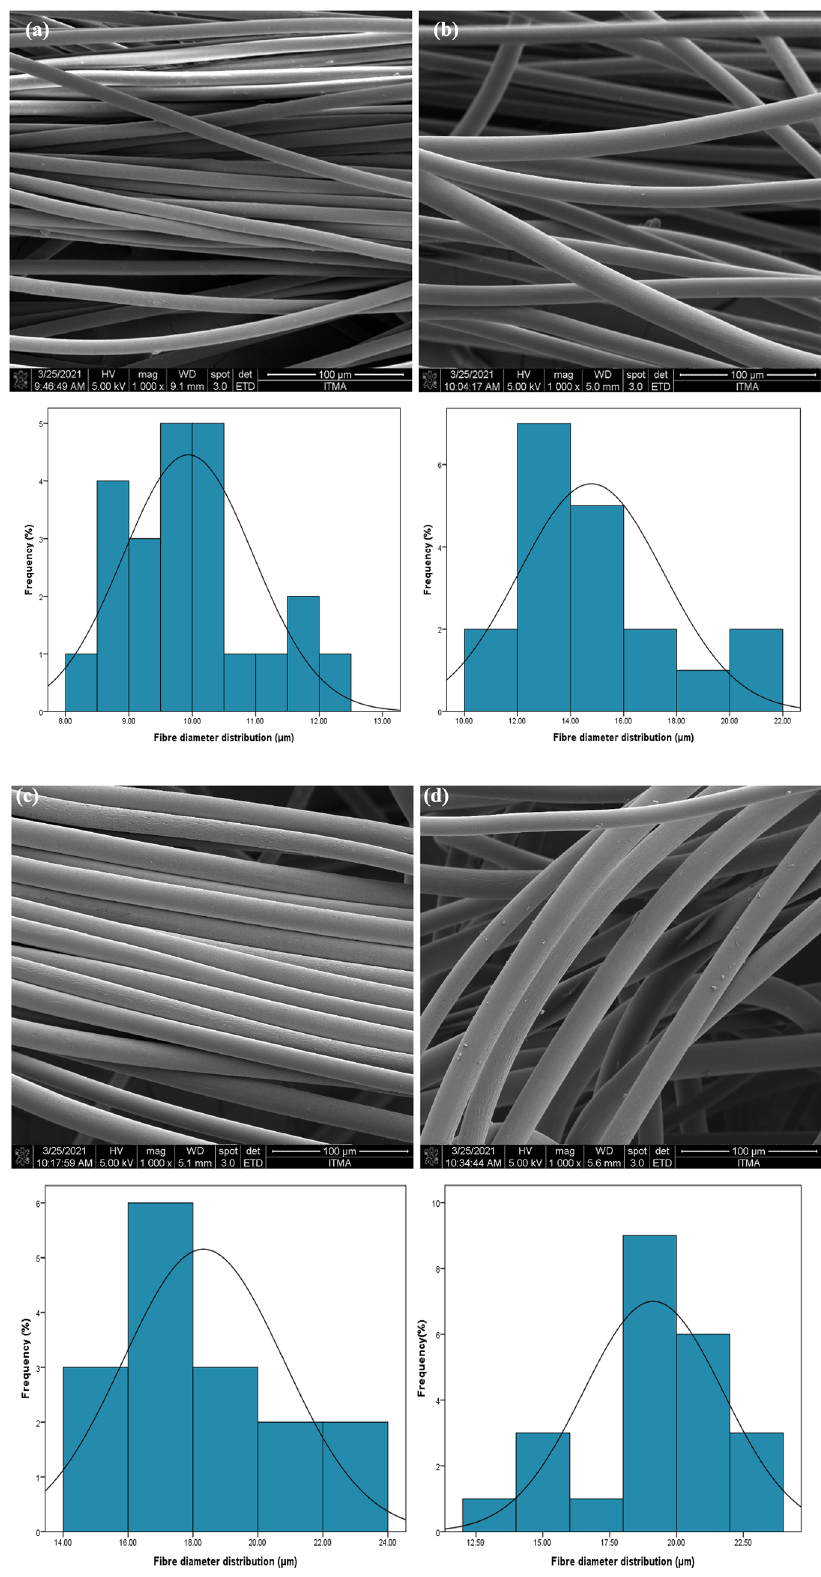
Figure 5. FESEM images of original PA6 ( a ), PA6- g -GMA ( b ), TMA-(PA6- g -GMA) ( c ), PNP loaded TMA- (PA6- g -GMA) ( d